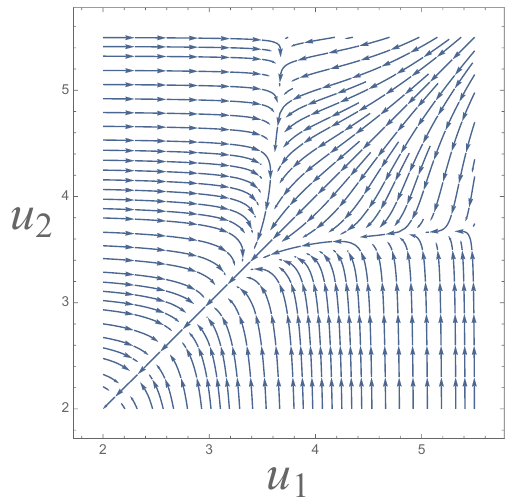
Figure 10 . Gradients of the in(cid:13)ationary potential. In the area where the slow-roll regime is possible (colored areas in (cid:12)gure 9), these gradients describe the in(cid:13)ationary slow-roll evolution of the (cid:12)elds u i . The (cid:12)elds starting their motion at the in(cid:13)ationary plateau in the right upper corner in (cid:12)gures 9 and (cid:12)gure 10 typically fall down towards one of the two streams, each of which can be approximately described as an (cid:11) -attractor with 3 (cid:11) = 1. Then these streams merge into one stream corresponding to 3 (cid:11) =